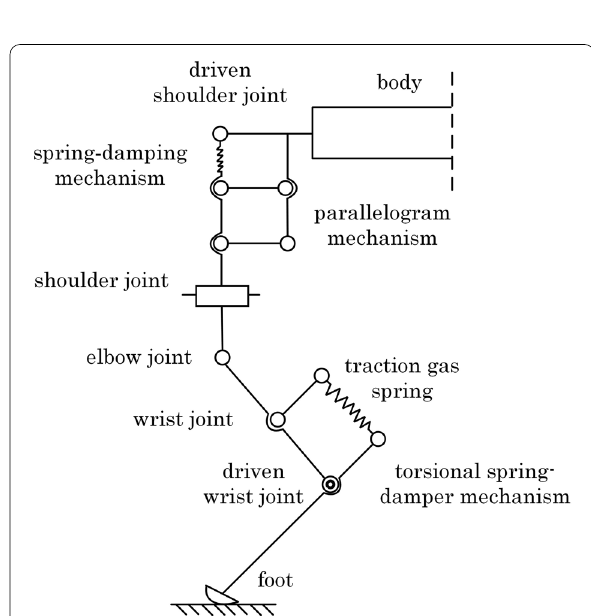
Figure 13 Structural sketch of the multistage buffer